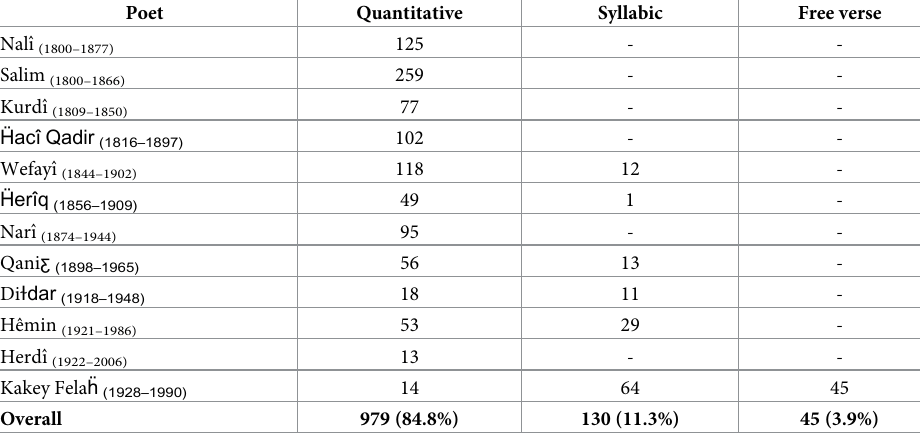
Table 6. Statistics of poems of the dataset. Poet